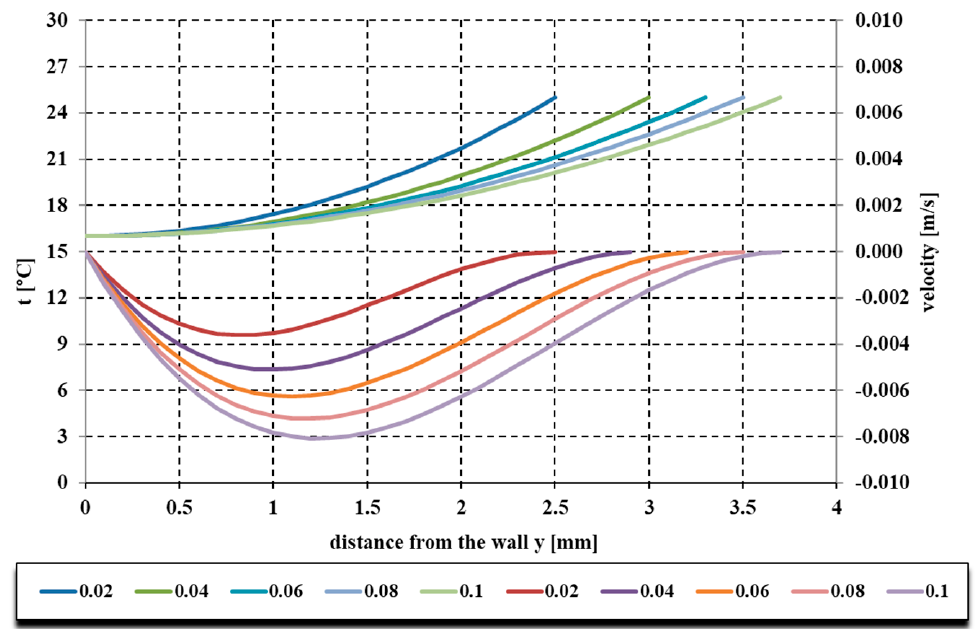
Figure 8. Dependence of rib height on velocity and temperature profile of the boundary layer. (wall temperature t w = 16 °C)